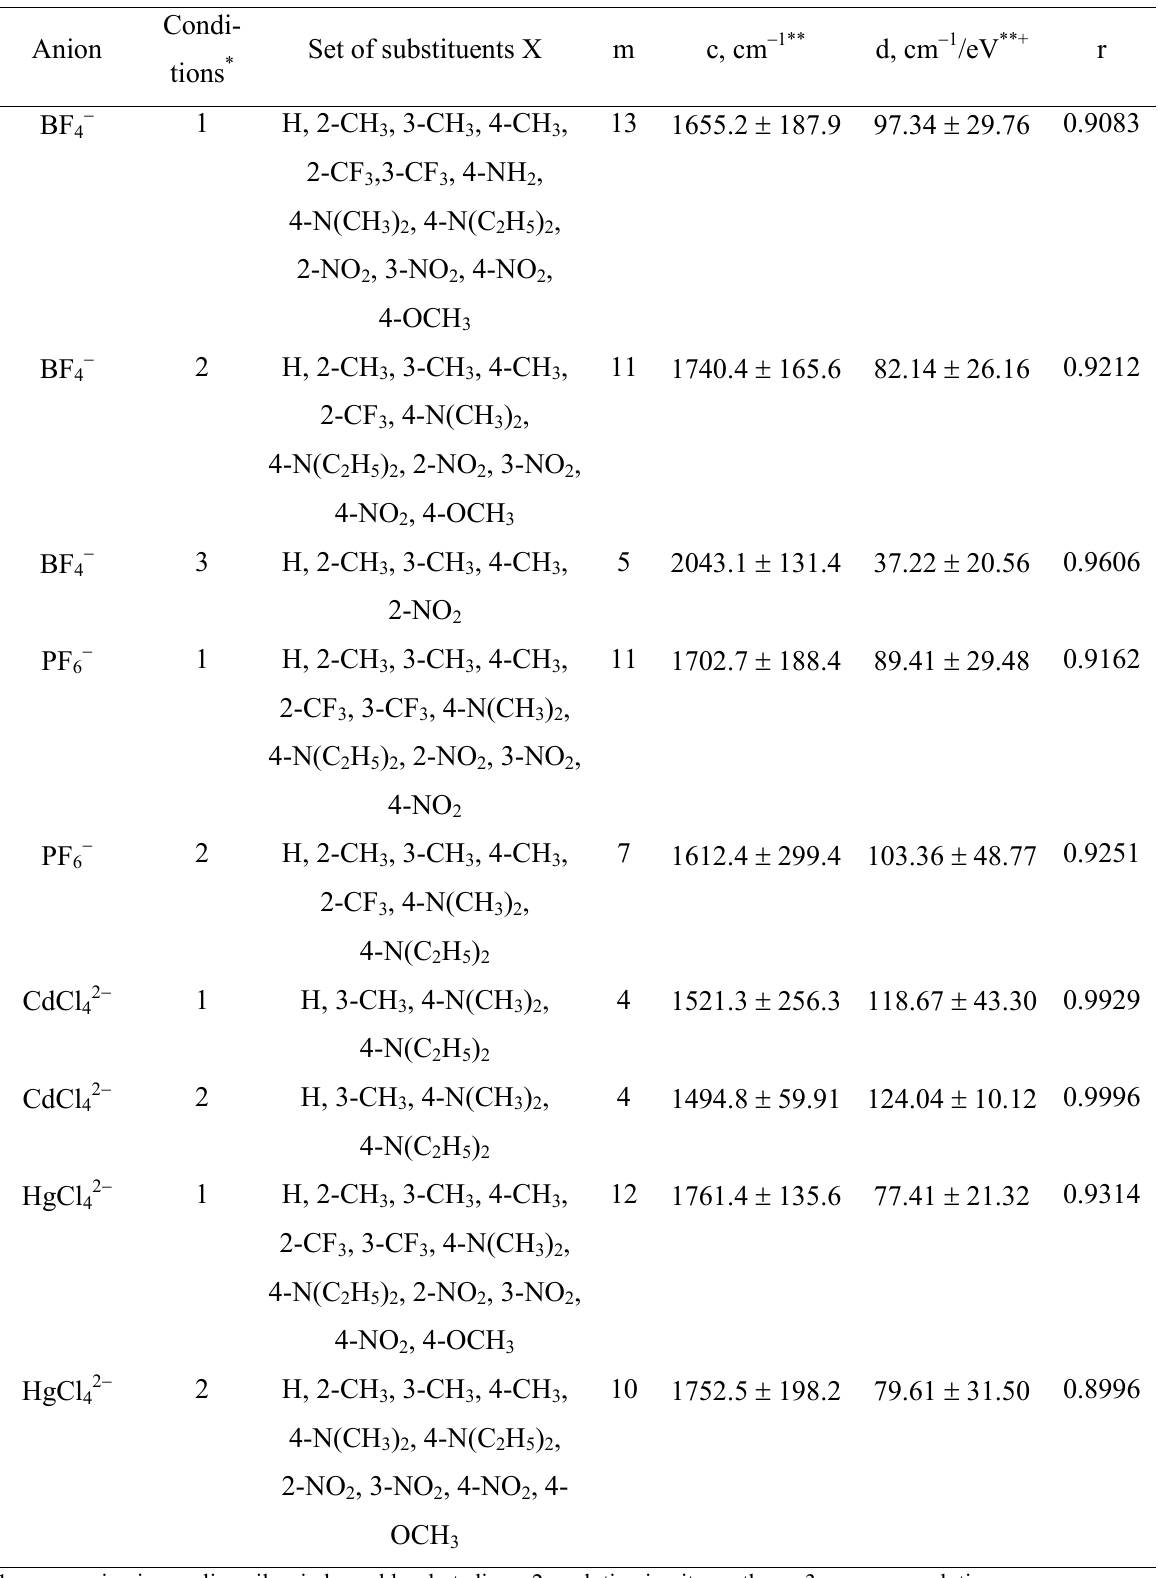
Table 5b. Interrelationships of stretching vibrational frequencies ( ν ) for fragment C-N + ≡ N bonds